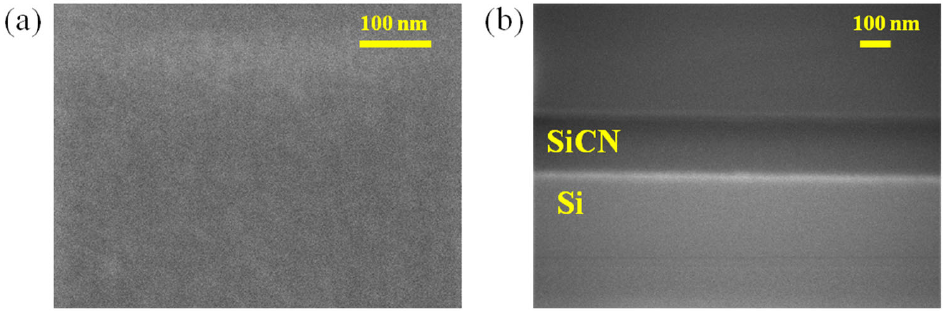
Figure 5. SEM images of SiCN films: surface ( a ) and cross ‐ section view ( b ).